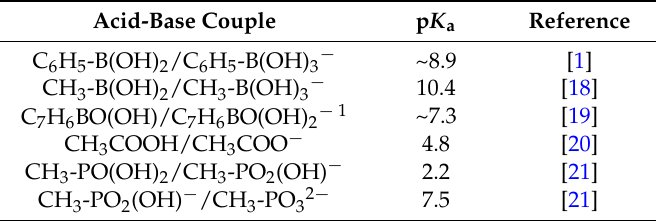
Table 1. p K a values (in water, at 25 °C) of simple boronic acids/benzoxaboroles, in comparison to other organic acids.